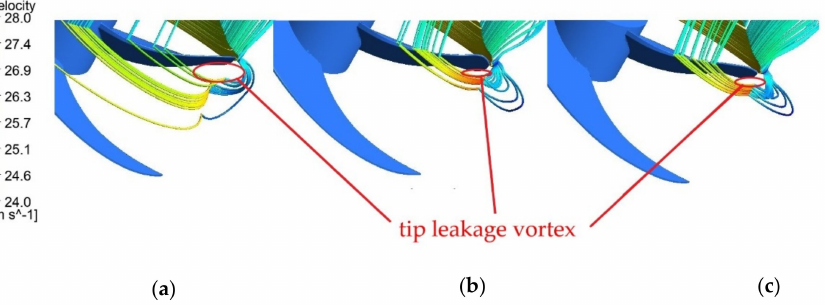
Figure 12. Three-dimensional flow line of tip leakage vortex: ( a ) Case-Basic, ( b ) Case-10, and ( c ) Case-12.